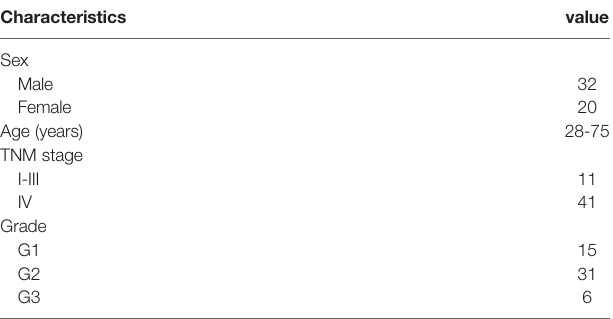
TABLE 1 | Basic clinicopathological characteristics in patients who underwent 68Ga-DOTANOC and 18F-FDG PET-CT. Characteristics